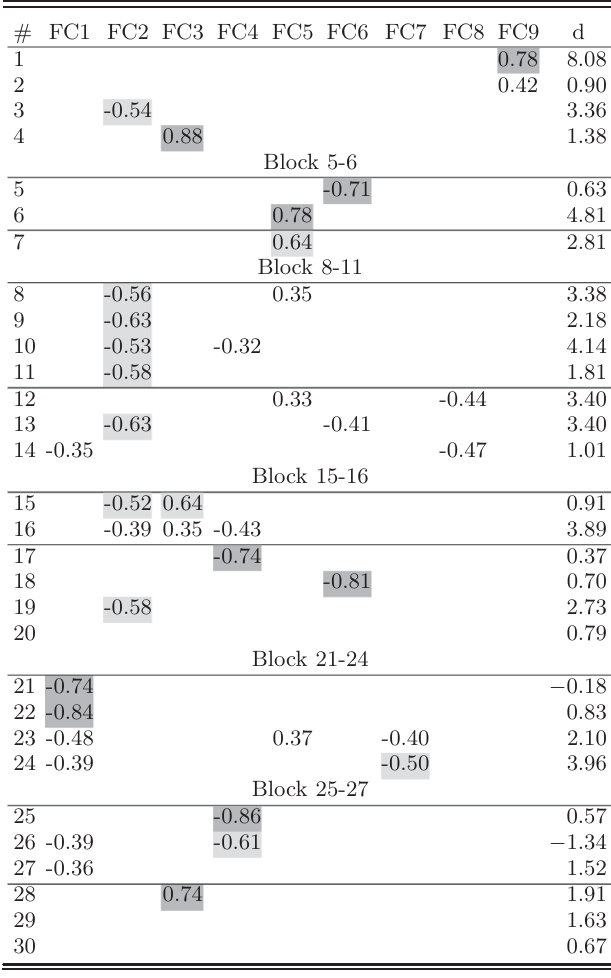
TABLE I. Factor loadings for exploratory factor analysis with Multidimensional IRT (varimax rotation). Loadings greater than 0.7 are highlighted in dark gray. Loadings between 0.5 and 0.7 are highlighted in light